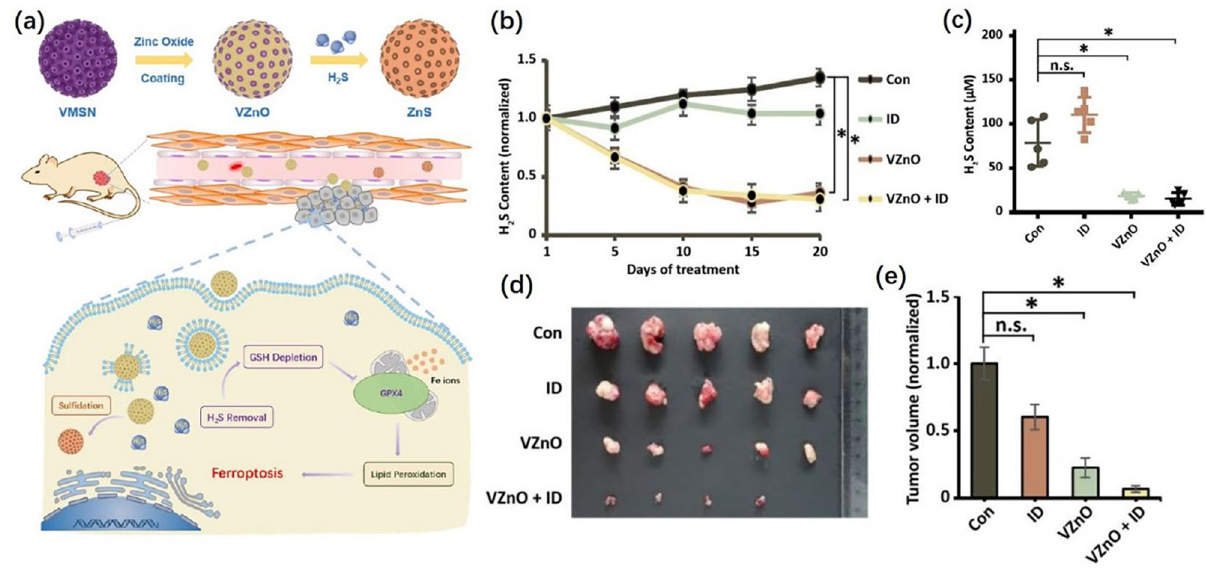
Figure 6: ( a ) Schematic illustration of VZnO synthesis and H 2 S depletion for CRC treatment. ( b ) Measurement of H 2 S content in the mouse model. ( c ) H 2 S content measured on day 14. ( d – e ) Photograph and volume of extracted tumors on day 14 in di ff erent treatment